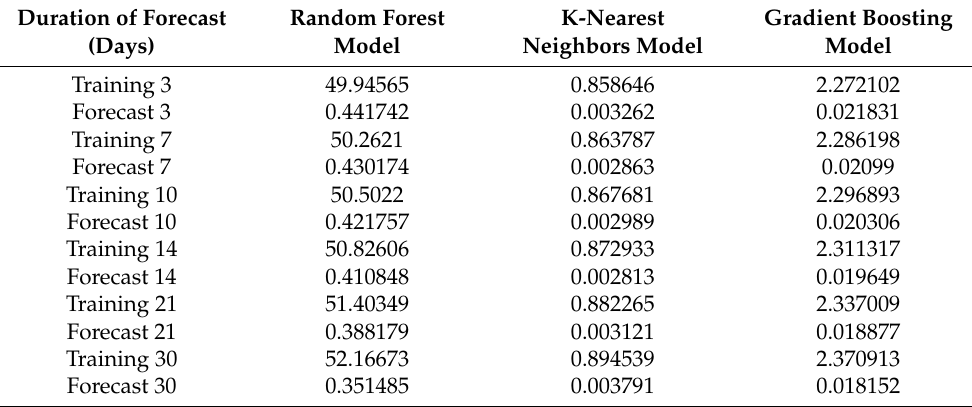
Table 2. Relative error of forecasted new cases for Japan